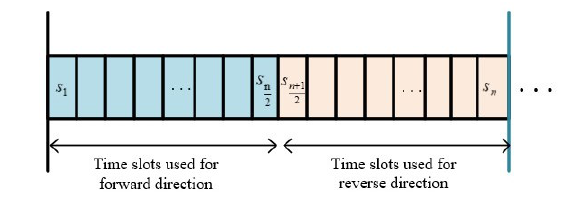
Figure 3. The time slot in a frame is divided into two time slot